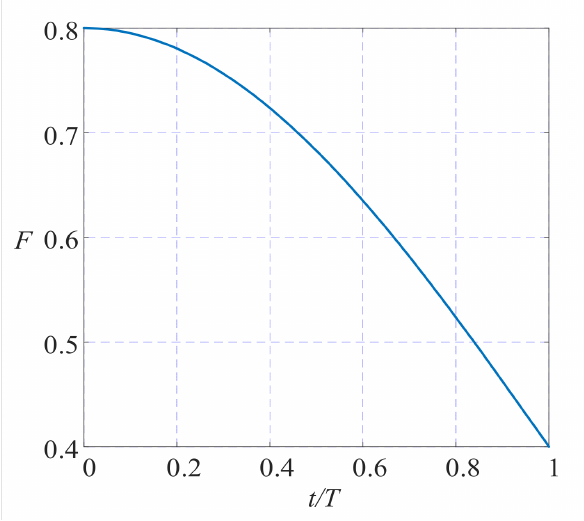
Figure 4. The adaptive curve of F